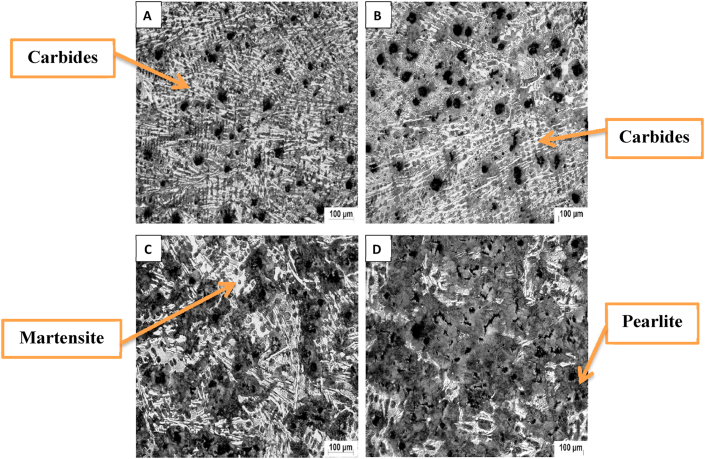
Pearlite % for sample number 1 with different thicknesses A) Wall thickness 5mm, pearlite % 59.5, B) Wall thickness 10mm, pearlite % 63.60, C) Wall thickness 15mm, pearlite % 62.17, and D) Wall thickness 20mm, pearlite % 81.81.